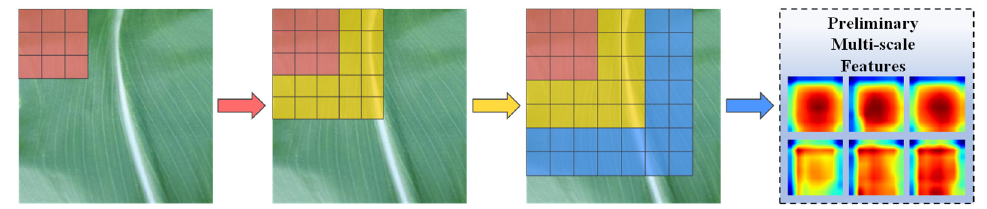
Figure 3. Schematic diagram of the multi-scale patch embedding.